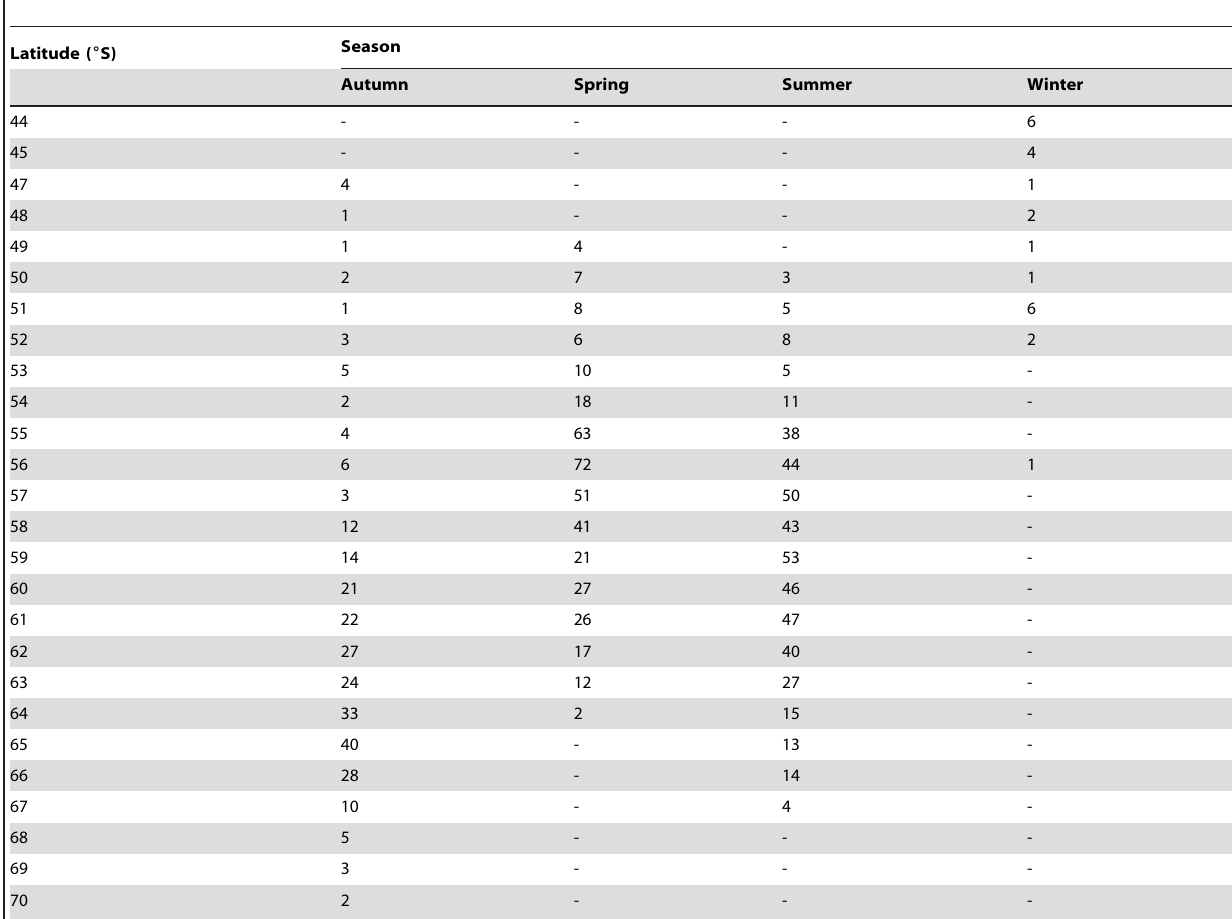
Table 2. Frequency of daily locations for each season by 1 u latitudinal